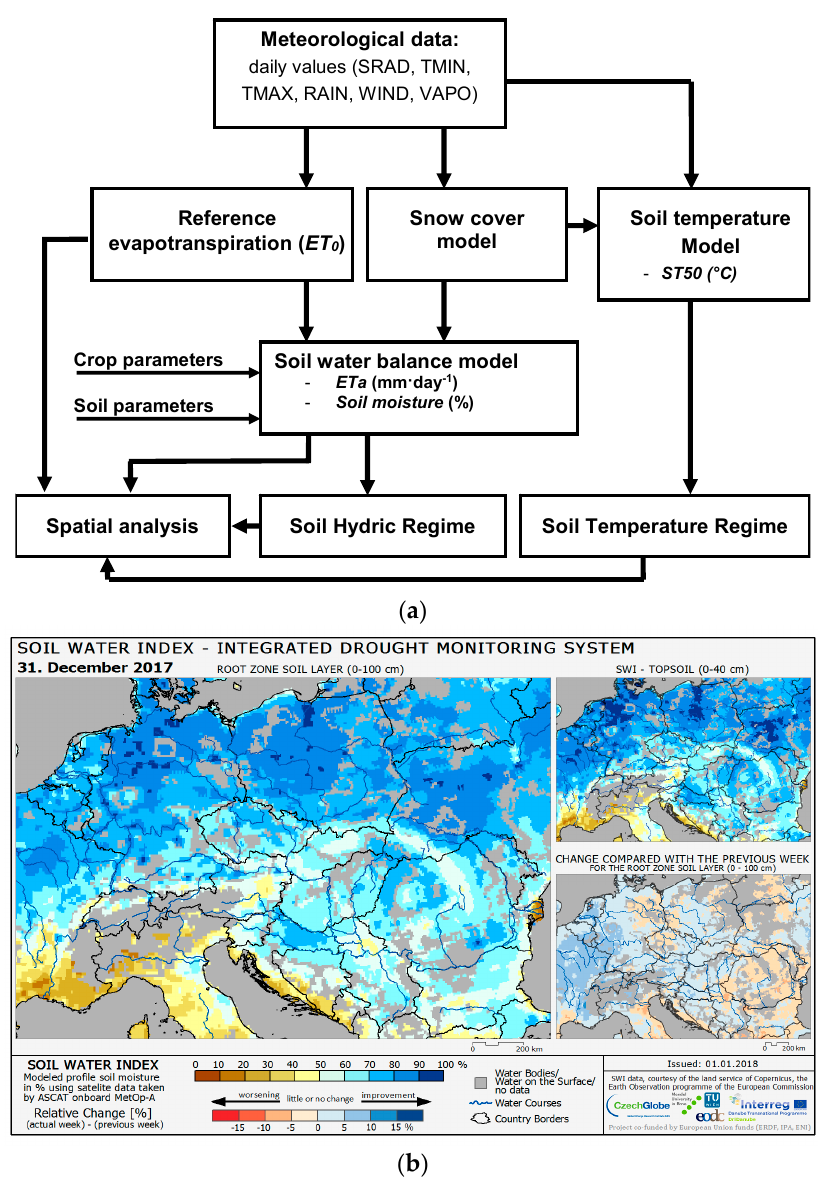
Figure 1. ( a ) Diagram of data processing in the soil moisture and drought intensity model SoilClim; ( b ) current area of interest covered by the weekly drought monitoring efforts.